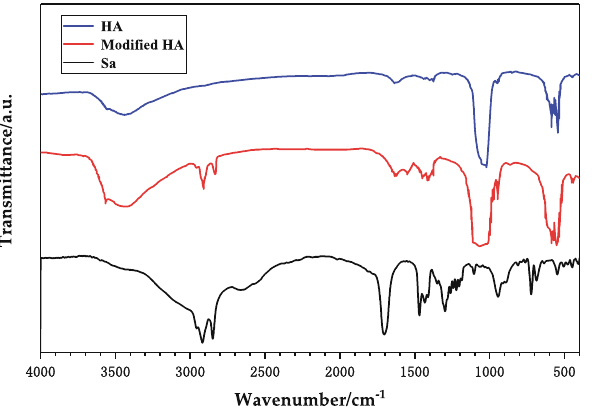
Figure 2: FTIR spectra of the original HA, modi fi ed HA, and Sa.